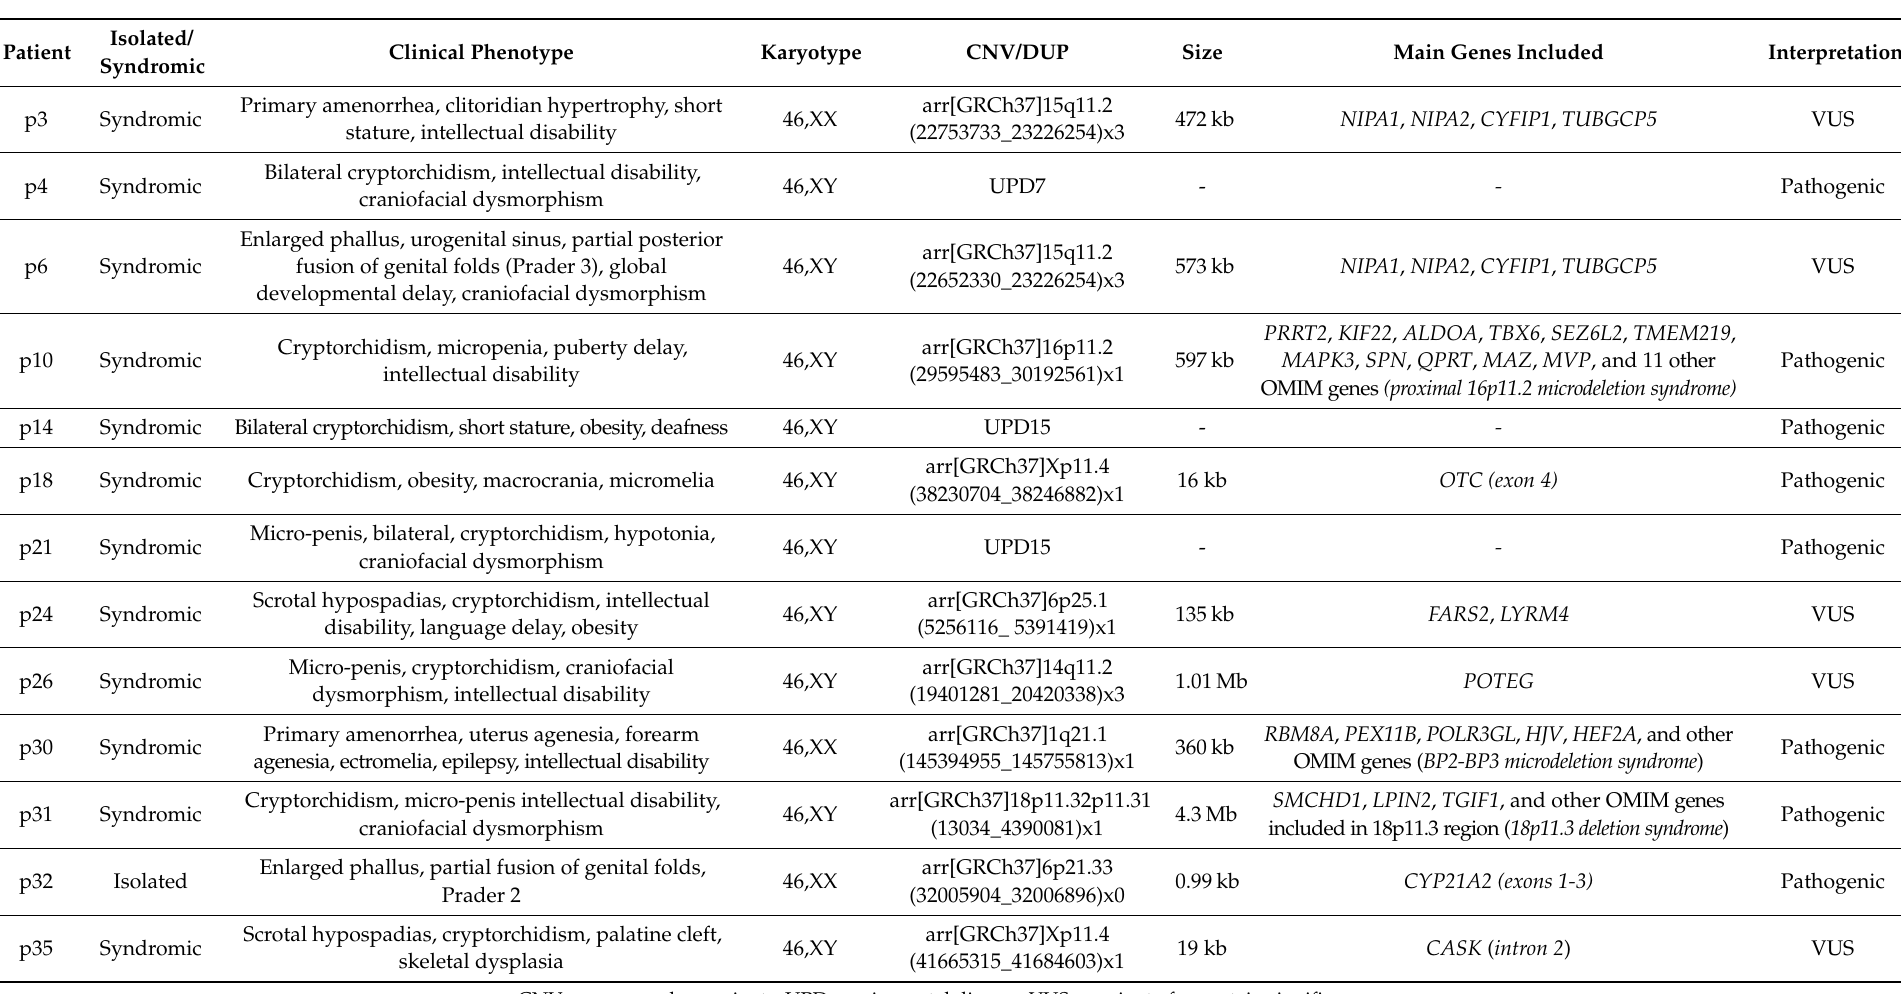
Table 2. Pathogenic CNVs and VUS observed in patients analyzed by SNP array